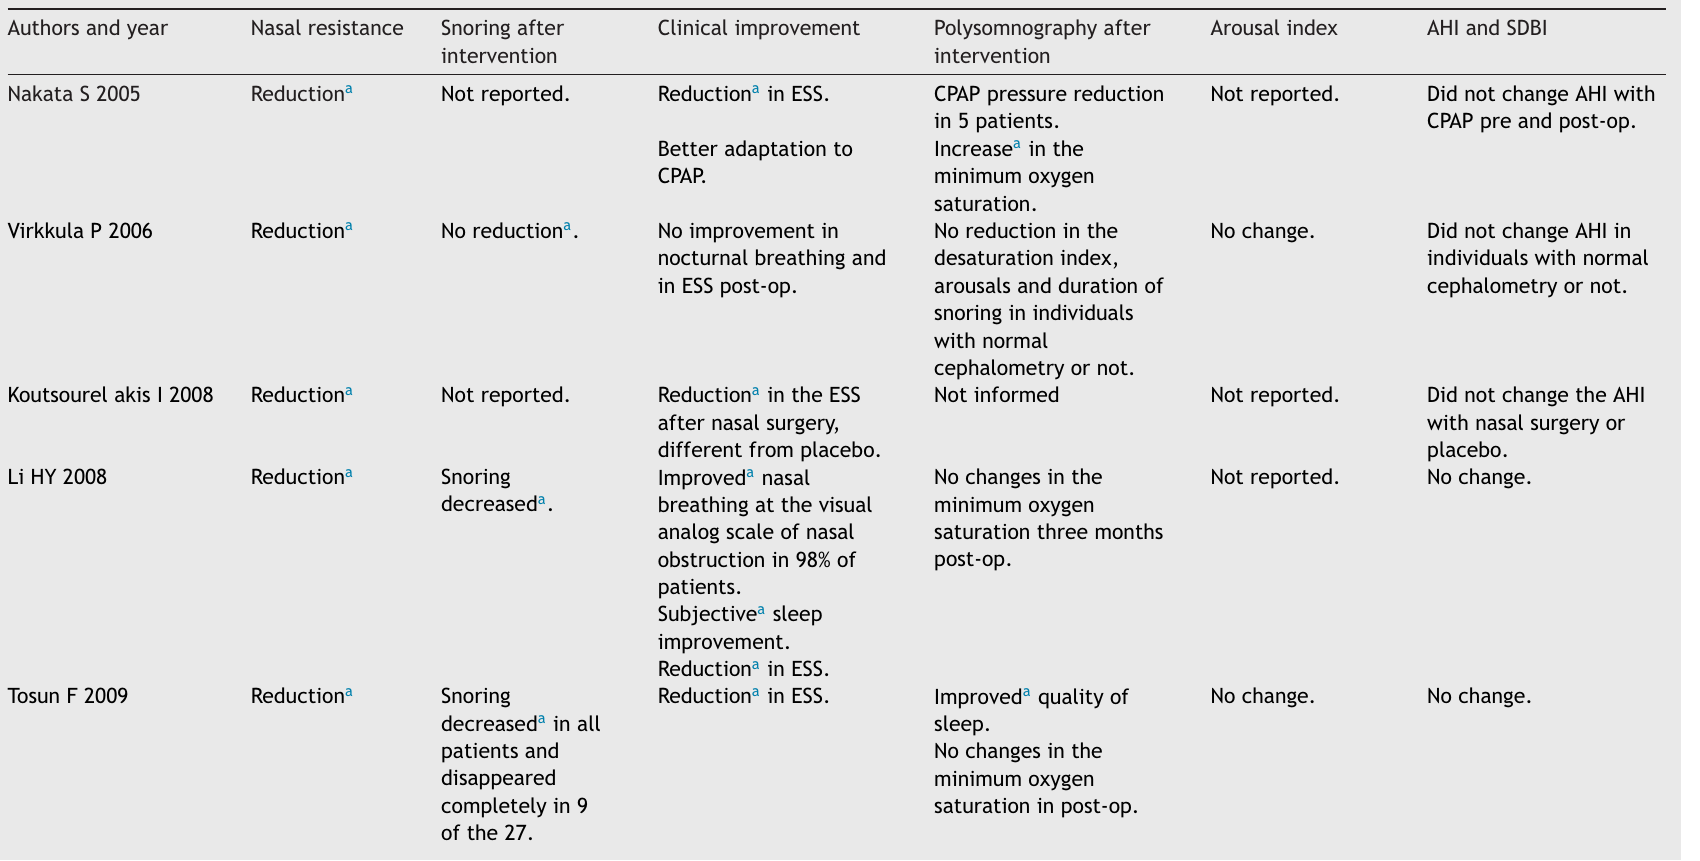
Changes with surgical